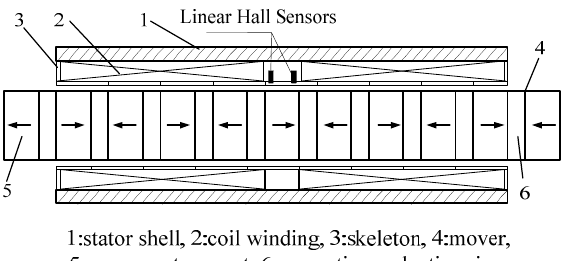
Figure 1. Diagram of PMTLM structure.